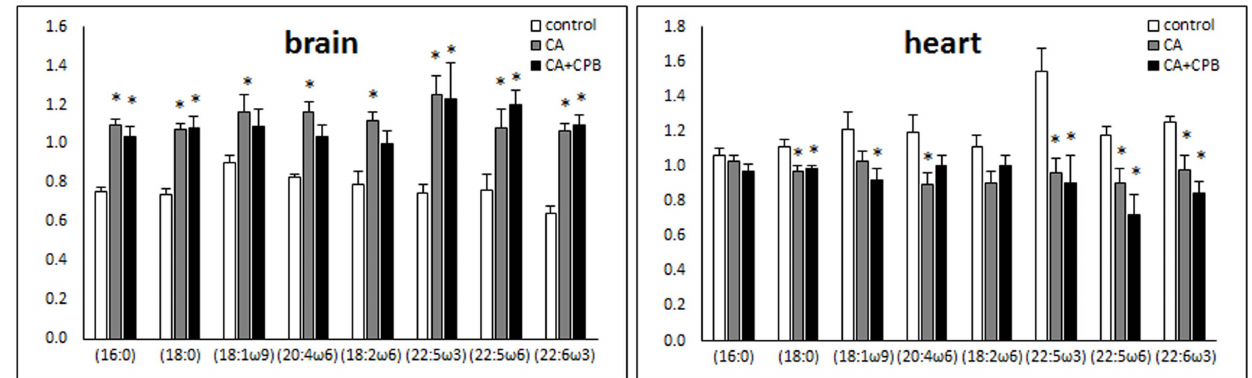
Figure 2. Changes in the relative amounts of free fatty acids in the heart (left) and the brain (right) after 30 min cardiac arrest and 30 min cardiac arrest followed by 60 min CPB (n=5).